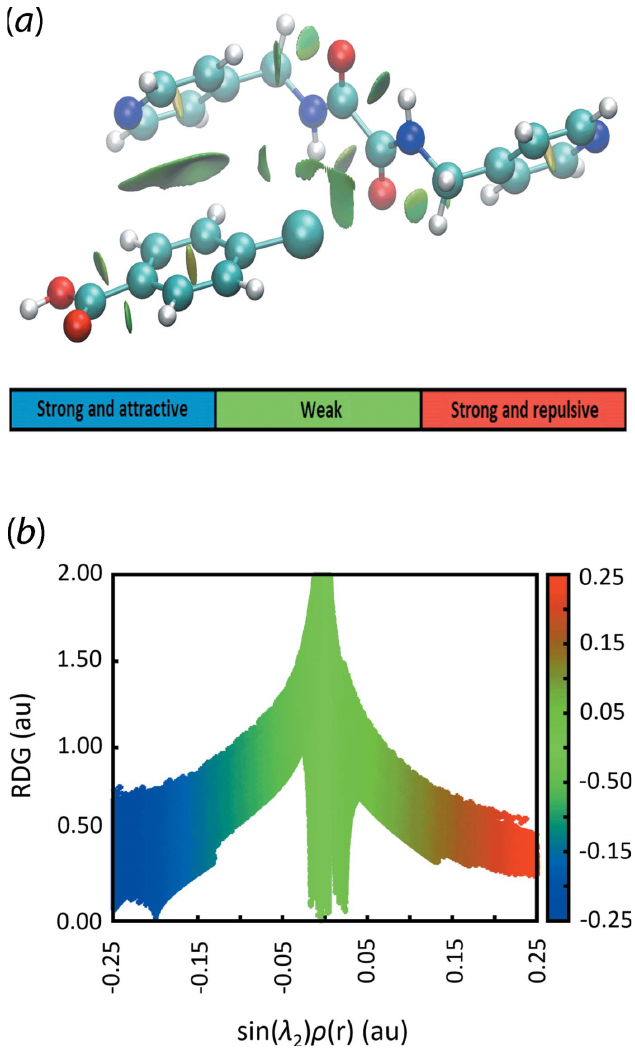
Figure 7 ( a ) The NCI plot highlighting the O (cid:2)(cid:2)(cid:2) Cl and C (cid:2)(cid:2)(cid:2) Cl contacts between 4 L H 2 -I and CBA-I molecules, showing the weak, but attractive inter- actions through the green domain and ( b ) the two-dimensional reduced density gradient versus the electron density times the sign of the second Hessian eigenvalue which reveals the overall contact profile of the pairwise molecules. The gradient cut-off is set at 0.4 and the colour scale is (cid:4) 0.25 < (cid:3) < 0.25 a.u.